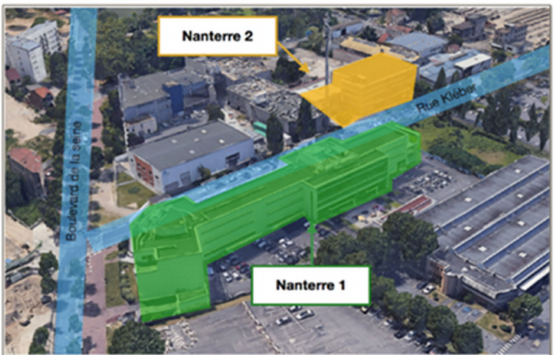
Figure 6. Location of Nanterre 2 (new) and Nanterre 1 (existing) buildings on Rue Kl é